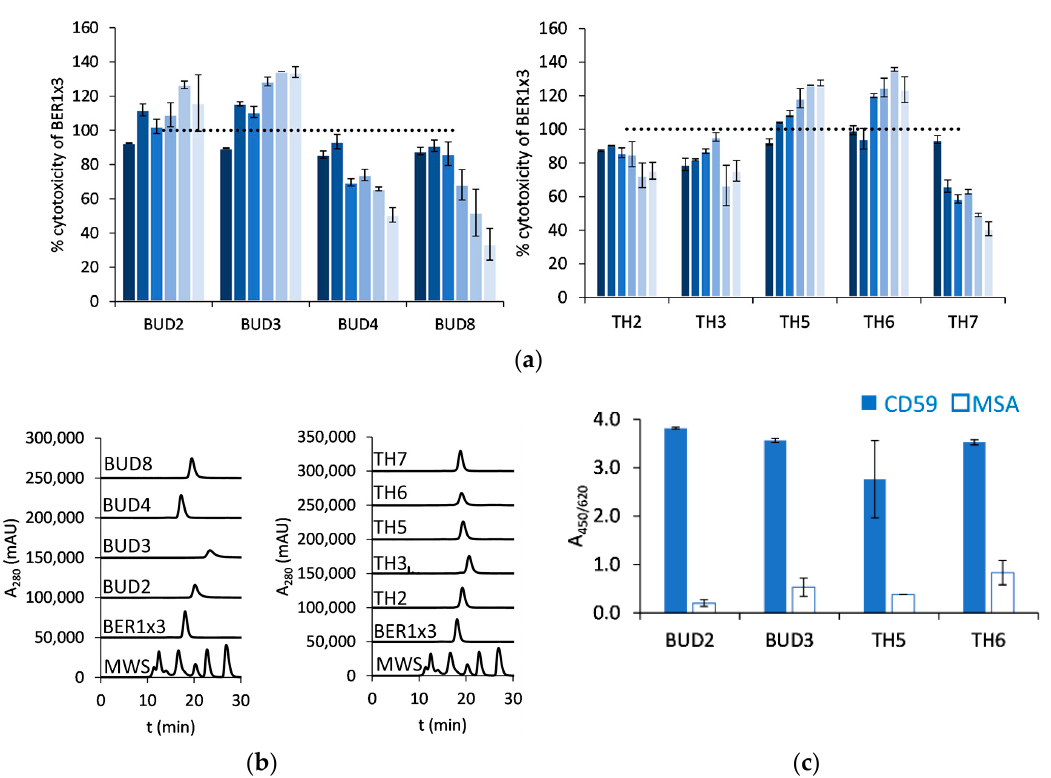
Figure 5. Affinity-matured BER1x3-derived clones from libraries BER1x3_4NNK (“BUD” clones) and BER1x3_5NNK (“TH” clones): ( a ) Complement-dependent cytotoxicity effect of rituximab (RX)-based mAb 2 molecules on Raji cells, compared with parental RX-BER1x3, in 2-fold dilutions starting from 30 nM, decreasing concentrations are presented from dark to light blue (sample size n = 2, mean and S.D. are presented); ( b ) HPLC-SEC in native conditions of RX-based mAb 2 molecules (MWS: molecular weight standard); ( c ) ELISA with CD59 and mouse serum albumin as a control antigen (sample size n = 2, mean and S.D. are shown).